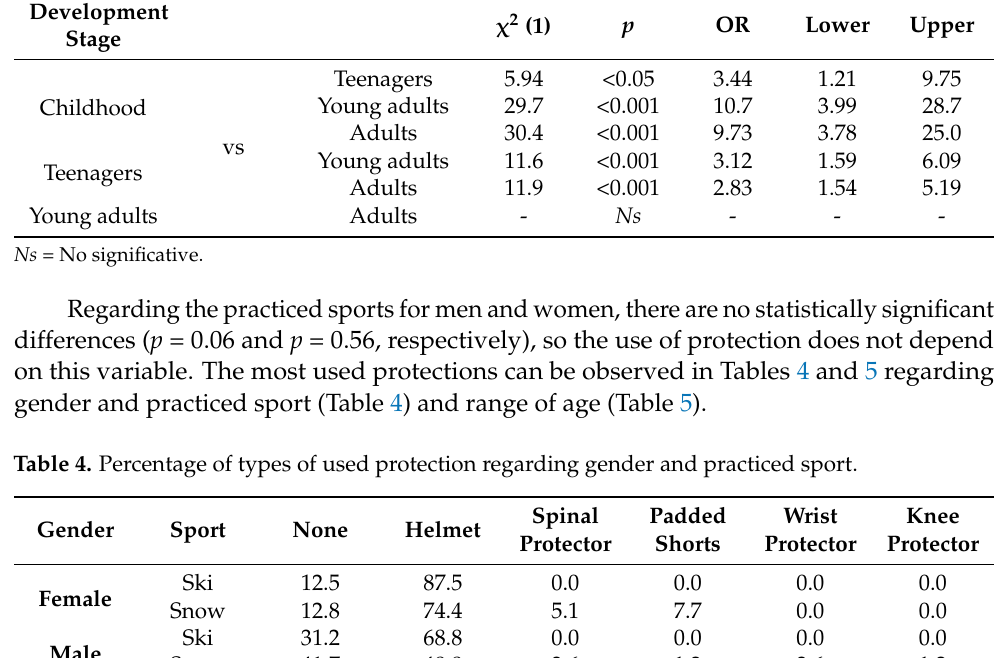
Table 5. Percentage of types of used protection regarding the range of age. None Helmet Childhood 4.7 0.0 Teenagers Young adults